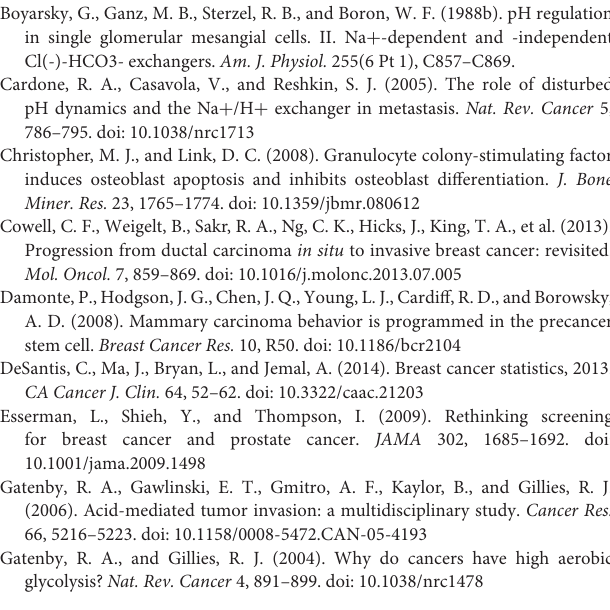
Figure S1 | Cartoon explaining how the NH 4 Cl washout protocol is used to measure pH i regulation after acidification. When NH 4 Cl is added to the superfusate, the concentrations of NH 3 in the intra- and extracellular fluids are assumed to be equivalent and, according to the isohydric principle, fixed intracellular buffers are considered to be in equilibrium with NH 3 +H + <> NH + 4 . In step 1, NH 3 enters the cell as a gas to raise pH i . In step 2 pH i falls as NH + 4 enters the cell via cation transporters. In step 3, NH 4 Cl is washed out of the extracellular space with Na-free media after which NH 3 gas exits the cell leaving excess protons behind and acidifying the cell. In step 4 normal Na is replaced in the superfusate and Na-dependent transporters regulate pH i . Figure S2 | Linear regression followed by analysis of covariance (ANCOVA) for the representative data of the pHi during the recovery phase (1400–1800s) of the ammonium washout experiment in nMEC, Met1, and PyVmT cells showed that the slope of the best-fit lines for both cancer cell types (Met1 and PyVm) were significantly different ( P < 0.001) compared with the slope of the best-fit line for nMEC (Met1 slope = 7.678 × 10 − 4 pH i sec − 1 , PyVmT slope = 1.008 × 10 − 3 pH i sec − 1 , nMEC slope = 1.721 × 10 − 4 pH i sec − 1 ). Figure S3 | Met1 cancer cells have a higher rate of intracellular acidification than nMEC cells during sodium washout experiments where proton extrusion is blocked by NHE1 inhibition. Linear regression analysis for nMEC and Met1 individual pHi values followed by analysis of covariance (ANCOVA) showed significant difference ( P < 0.001), between the slopes of the best-fit lines (Met1 slope = 2.037 × 10 − 4 pH i sec − 1 , nMEC slope = 0.617 × 10 − 4 pH i sec − 1 ). The more negative slope from the Met1 cell data suggests more rapid proton production compared with